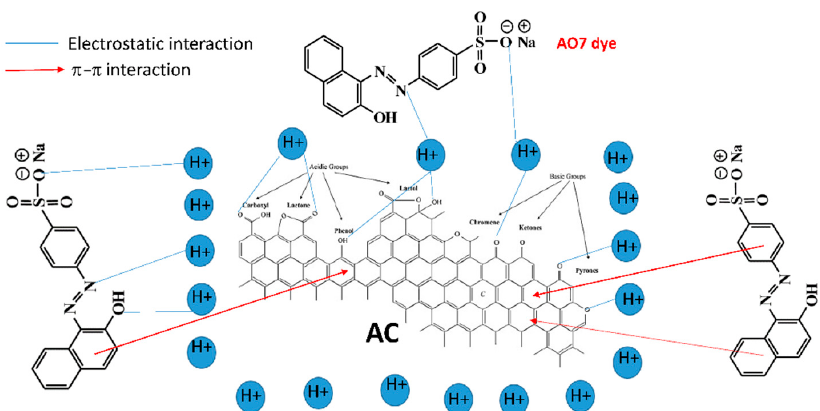
Figure 12. Shows the possible adsorption mechanisms of the adsorption of AO7 dye onto the microporous surface of activated carbon (AC-ZnCl 2 ) produced at 800 ◦ C under CO 2 gas through electrostatic interaction and π – π